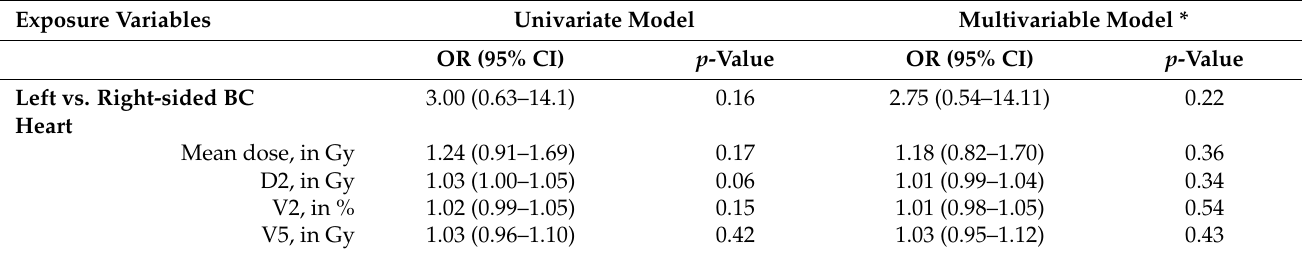
Table 6. Association between LAD CAC progression (yes/no) and cardiac exposure